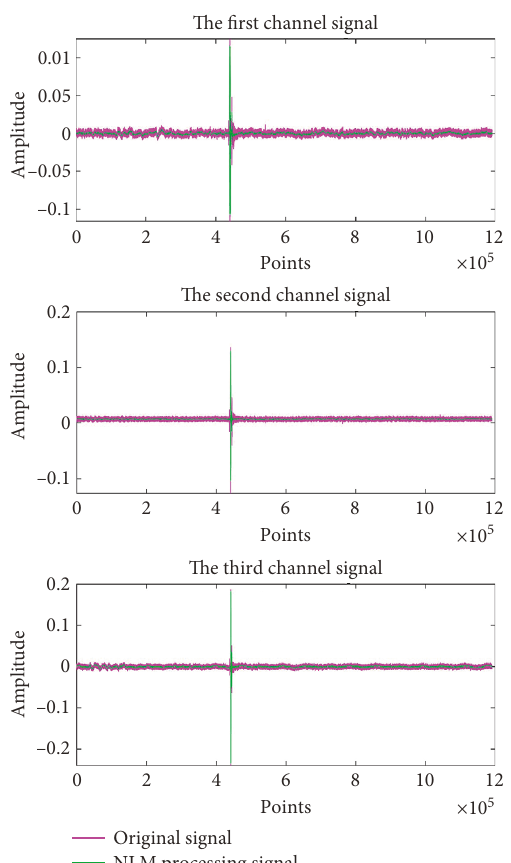
Figure 21: Comparison of the original value of the three-way signal and the NLM processing